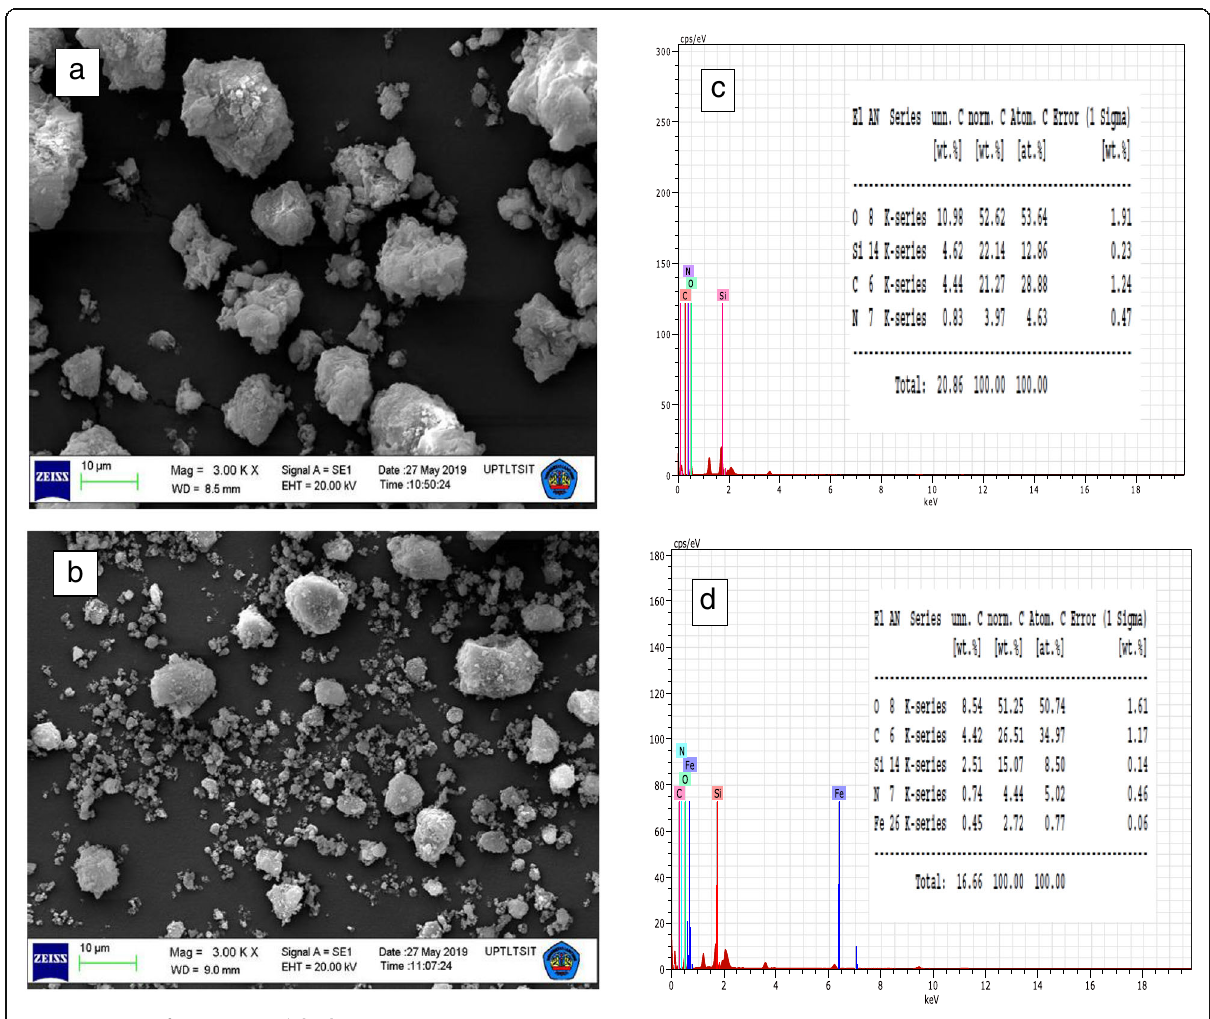
Fig. 2 SEM-EDX of ( a , c ) ASN and ( b , d ) ASN-MPs